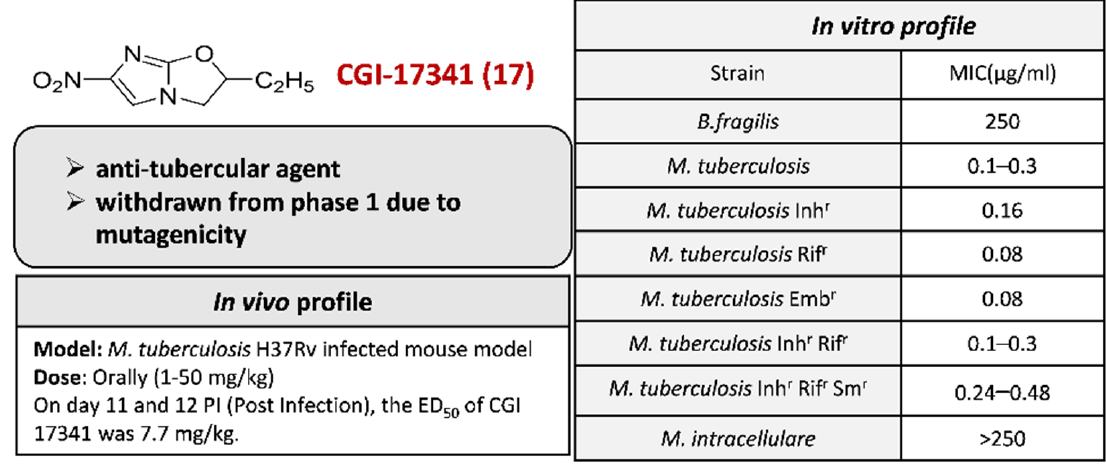
Figure 21. Activity profile of CGI-17341 17 [16].